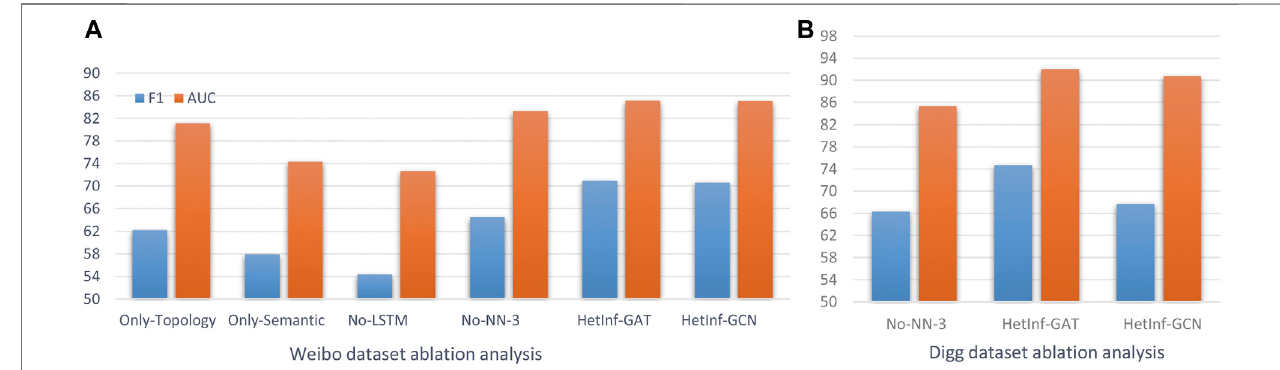
FIGURE 3 | Performances of variant proposed models (A) eibo dataset ablation analysis. (B) Digg dataset ablation analysis.